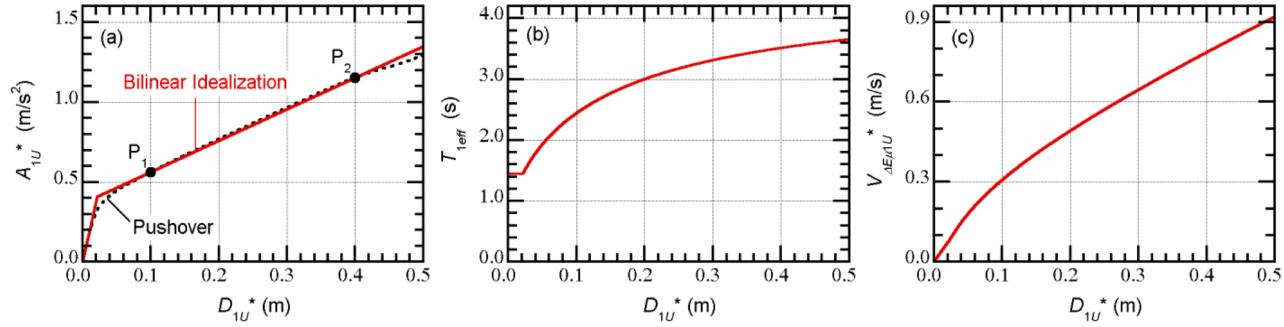
Figure 18. Nonlinear properties of the equivalent single-degree-of-freedom (SDOF) model representing the first modal re- sponse (Model-Tf44): ( a ) The A 1 U * − D 1 U * relationship; ( b ) the T 1 eff * − D 1 U * relationship; ( c ) the V ∆ E µ 1 U * − D 1 U *